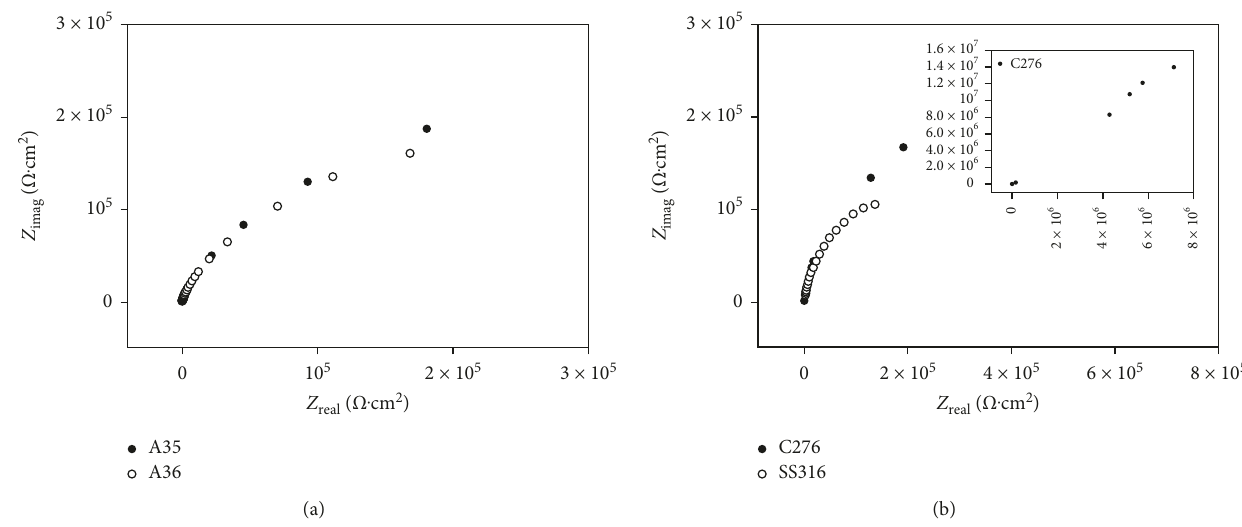
Figure 8: Nyquist plots of A35, A36, C-276, and SS316 alloys in 3.5 wt.% NaCl solution at 25 ° C.